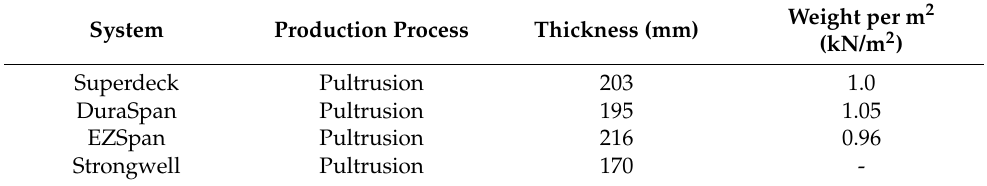
Table 1. Physical properties of plate systems from adhesively bonded pultruded profiles [6].